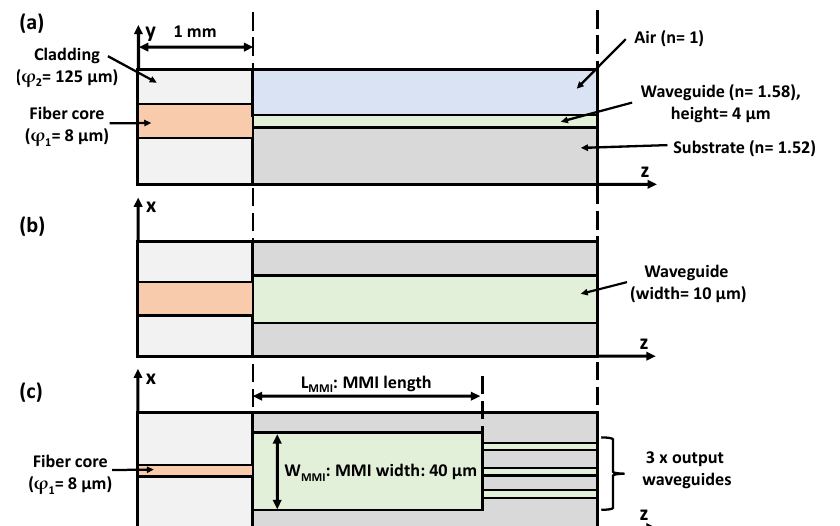
Figure 3. Schematic of the different designs computed with the BPM. ( a ) YZ-plane representing the TiO 2 –SiO 2 waveguide (n= 1.58) deposited on soda-lime glass (n= 1.52) and surrounded by air (n= 1). ( b ) Corresponding XZ-plane (top-view). ( c ) Modeling of the 1 × 3 MMI coupler (top-view) with a fixed width of 40 µm. In any case, all simulations were performed at 600 nm. The laser is injected through a butt-coupling approach using an SMF28 optical fiber.